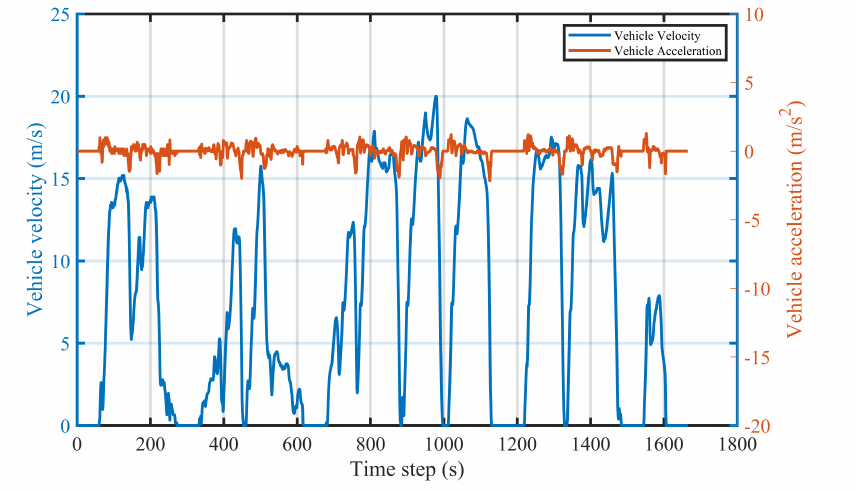
Figure 15. The velocity and acceleration of the